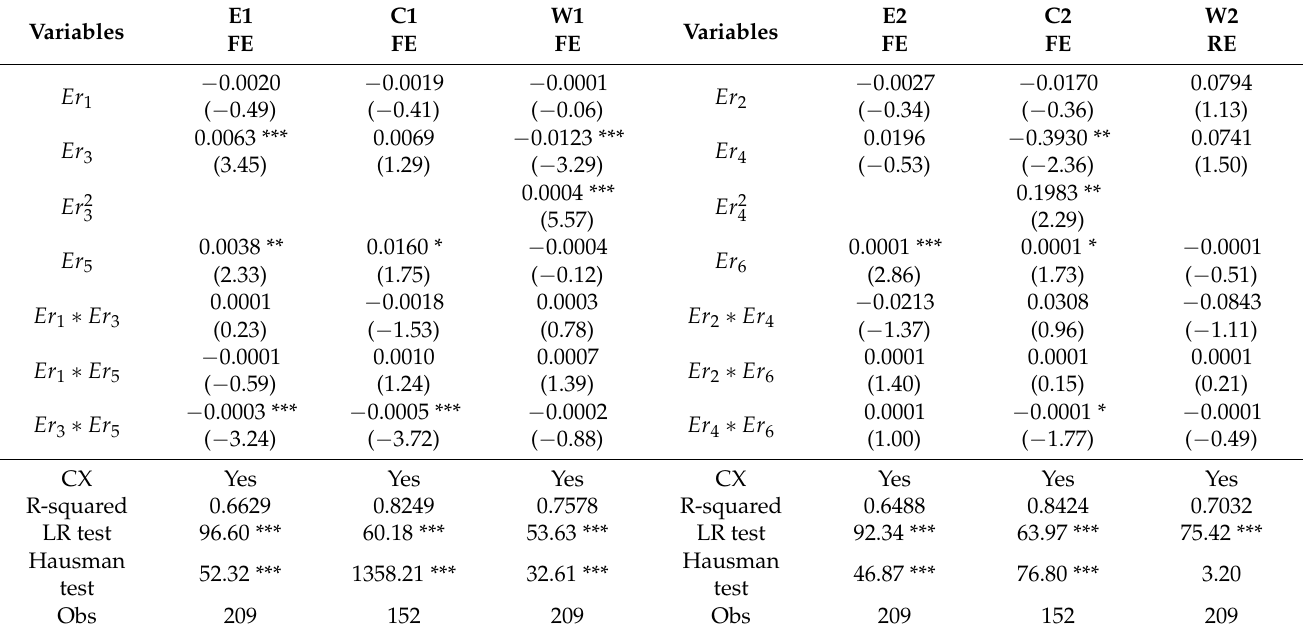
Table 10. Regression of interaction effect of different environmental regulations: Three